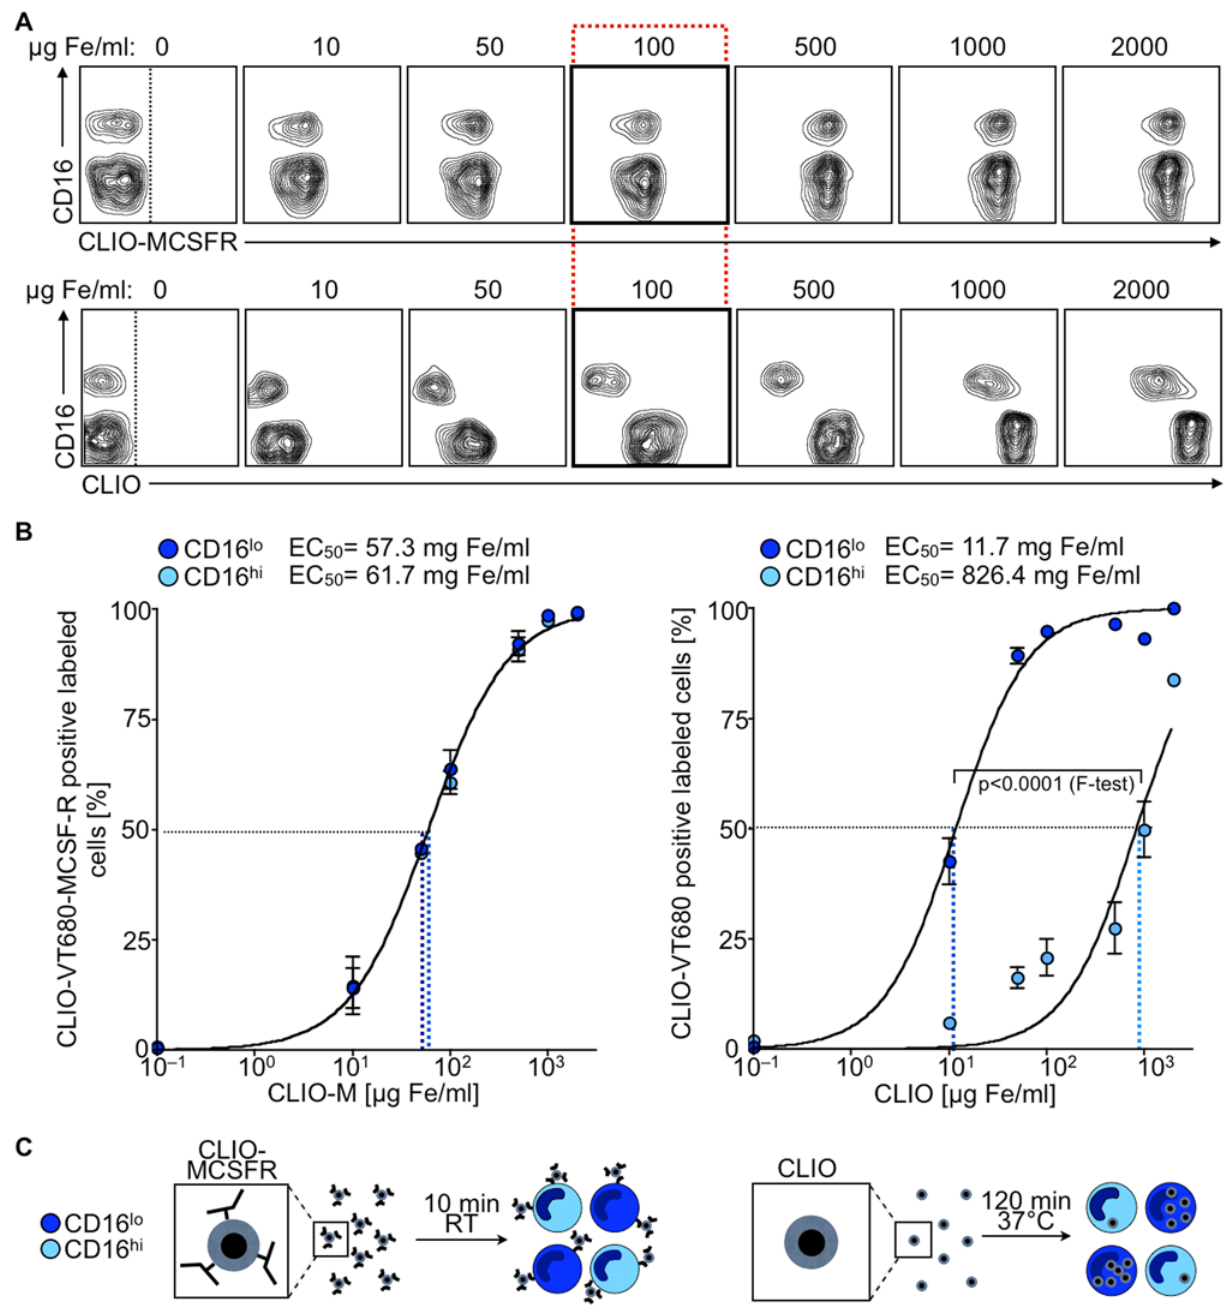
Figure 2. Nano-sensors discriminate between monocyte subsets optically. A. Representative flow cytometry contour plots of human monocytes labeled with increasing concentrations of fluorescent superparamagnetic nano-particles CLIO-MCSFR (top row) and CLIO (bottom row). To discriminate between subsets the mean fluorescent intensity of the particle (x-axis) is plotted against expression of CD16 (y-axis). B. Fe concentrations for both nano-particles (CLIO-MCSFR and CLIO) are log-transformed (x-axes) and plotted against % of positive labeled cells (y-axes). A sigmoidal dose-response curve is generated to calculate the corresponding EC 50 (nano-particle concentration at which 50% of each monocyte subset is labeled). N=4. C. Principle of the assay. The principle postulates that equal binding of subsets with CLIO-MCSFR will occur after 10 min at RT while incubation of subsets with CLIO at 120 min at 37 u C will result in preferential uptake of the particle by CD16 lo monocytes.